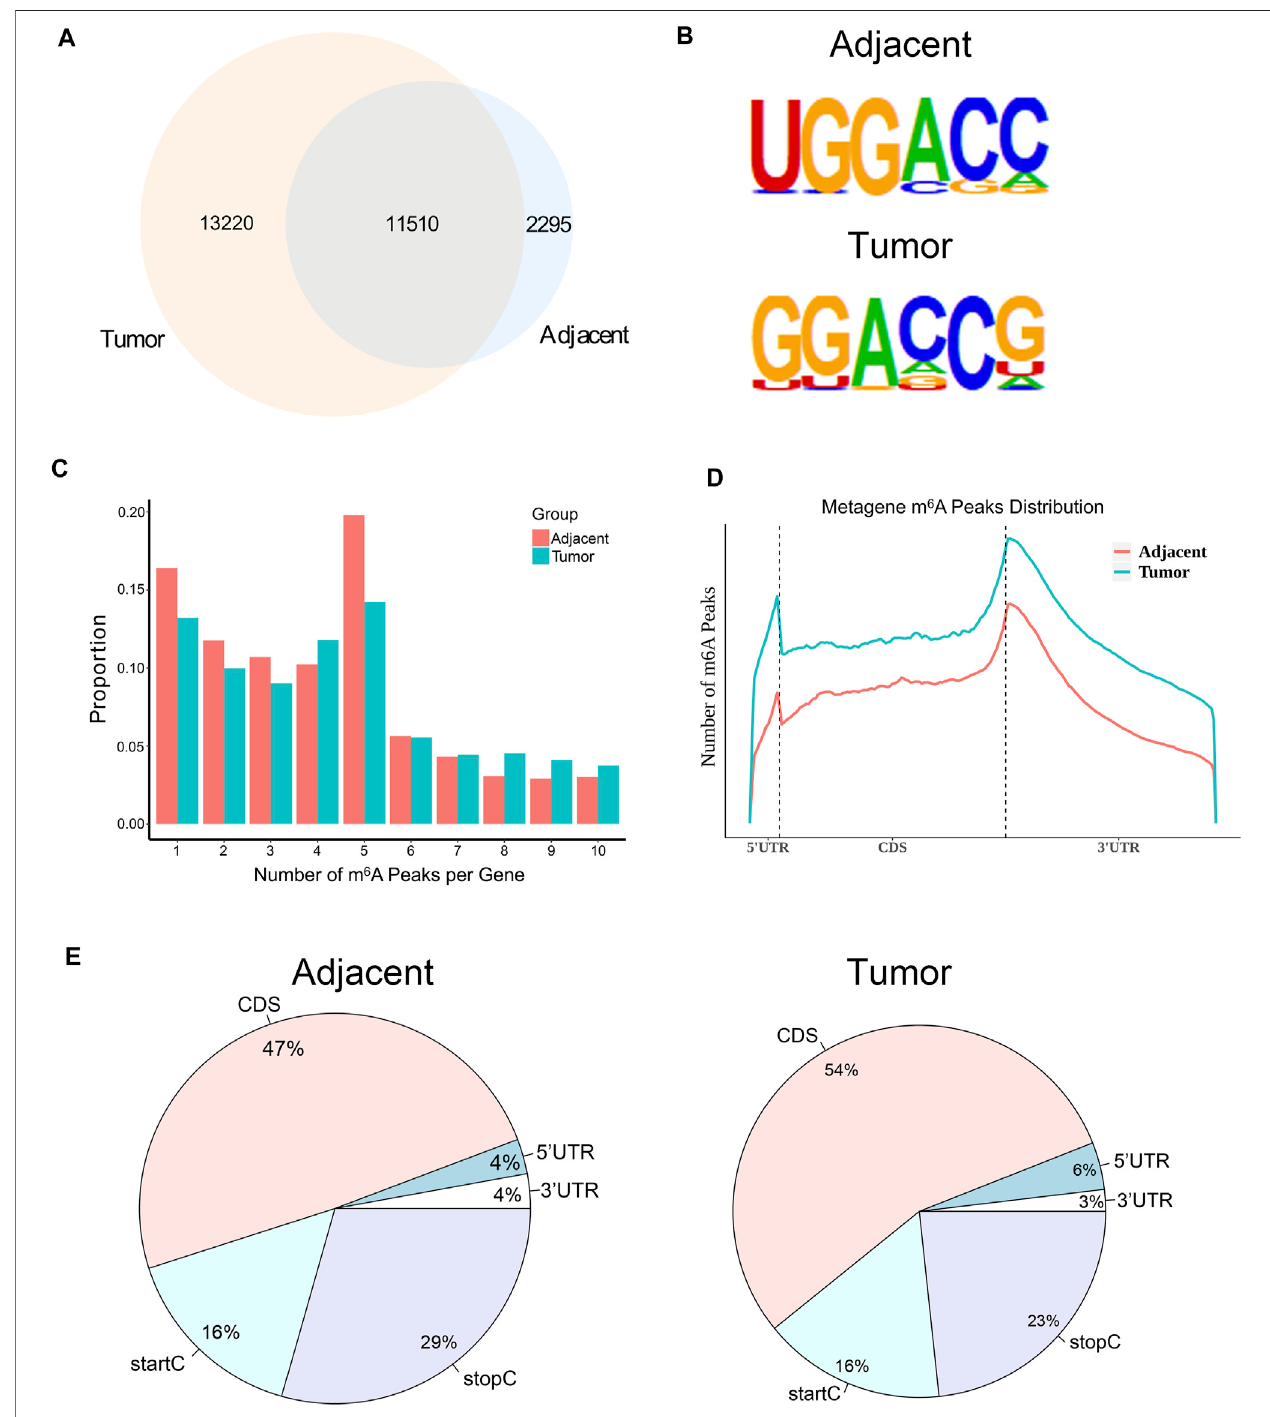
FIGURE 2| The mRNA m 6 A pro fi le of fi ve paired renal tumor tissuesand adjacent tissues. (A) The Venn diagram showing the numbers of m 6 A peaks in tumor and adjacent tissues. (B) The sequence motif of m 6 A-containing peak regions in tumor and adjacent tissues, respectively. (C) The distribution of m 6 A modi fi cations in the human transcriptome. (D) The metagene pro fi les of transcripts peaks in RCC tissues and adjacent tissues. (E) The proportion of m 6 A peaks located at transcripts. startC, start codon; stopC, stop codon.